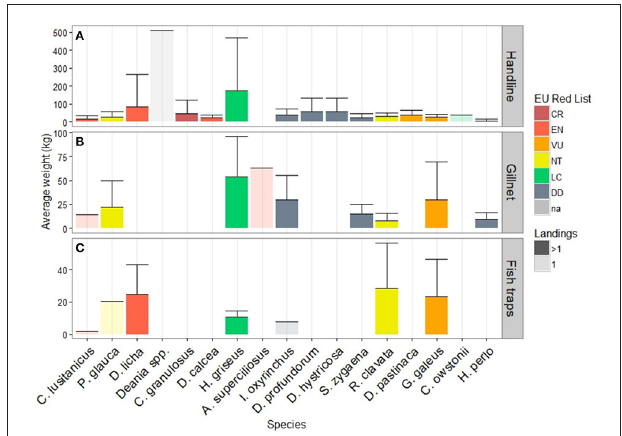
FIGURE 7 | Species composition, by regional Red List status, and average weight per landing of remaing métiers (considering only landings with elasmobranch); semi-transparent bars for species with only one landing record. NB, Y-axis different for each panel. (A) Handline, (B) Gillnets, (C) Fish